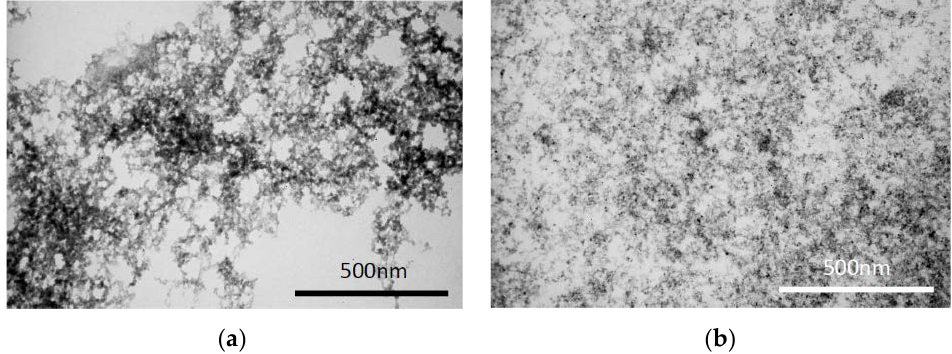
Figure 2. Representative TEM images of ( a ) uncoated iron oxide nanoparticles (IONPs) and ( b ) Dextran-70 coated IONPs. Scale bar = 500 nm.